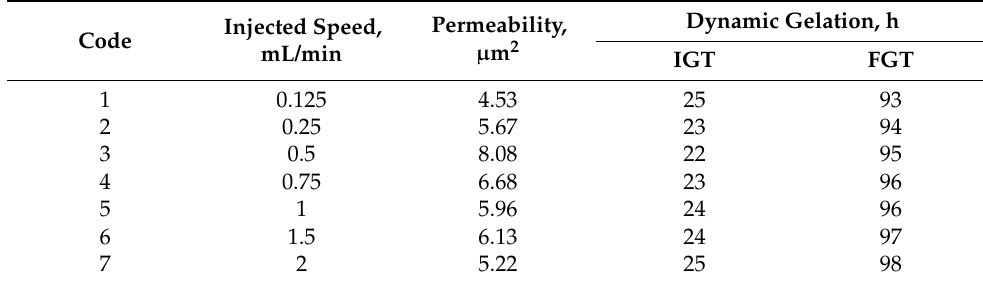
Table 1. Gelation times of dynamic gelation in porous media under different injection